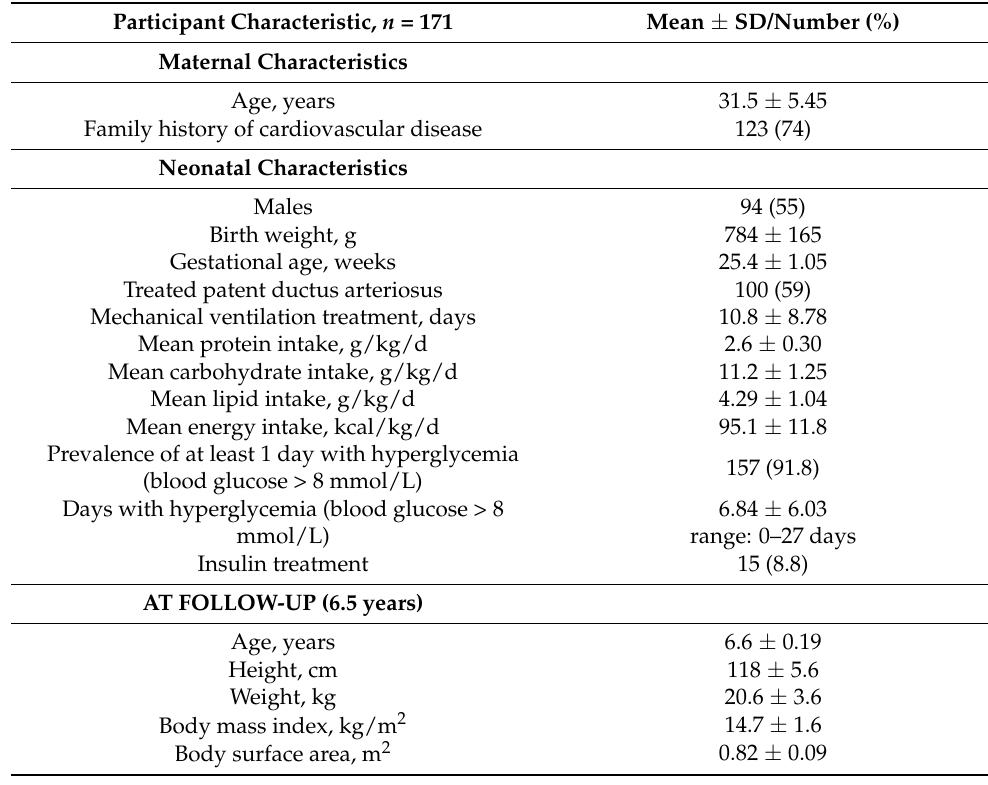
Table 1. Characteristics of the study